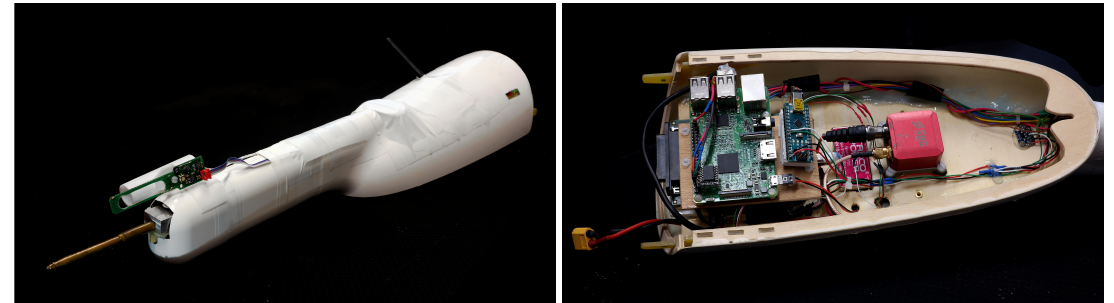
Figure 5. Sensor system hat ( left ) and mounted electronics inside the sensor hat ( right